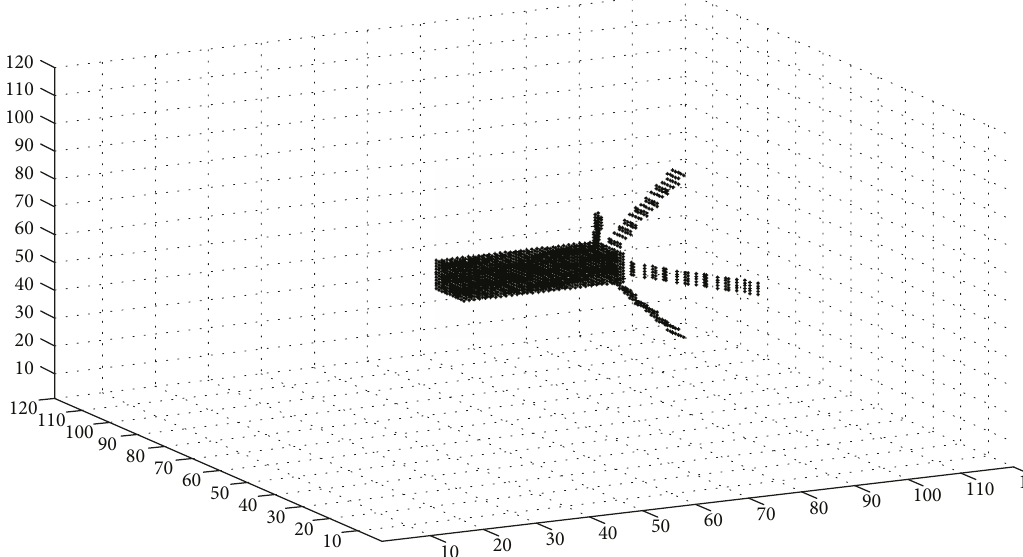
Figure 3: Geometric representation of a hypothetical 3U CubeSat with deployable side panels. This representation is used in SNAP for aerodynamic torque